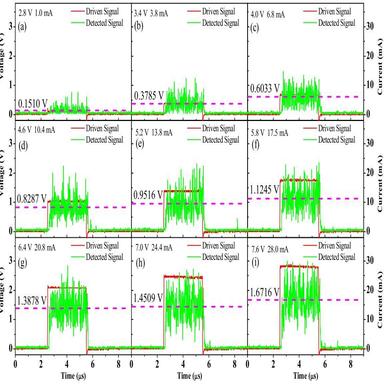
9 sets of detected signals (in green) through the MPPC and driven signals (in red) of the LED obtained from the DSO. (For interpretation of the references to colour in this figure legend, the reader is referred to the web version of this article).